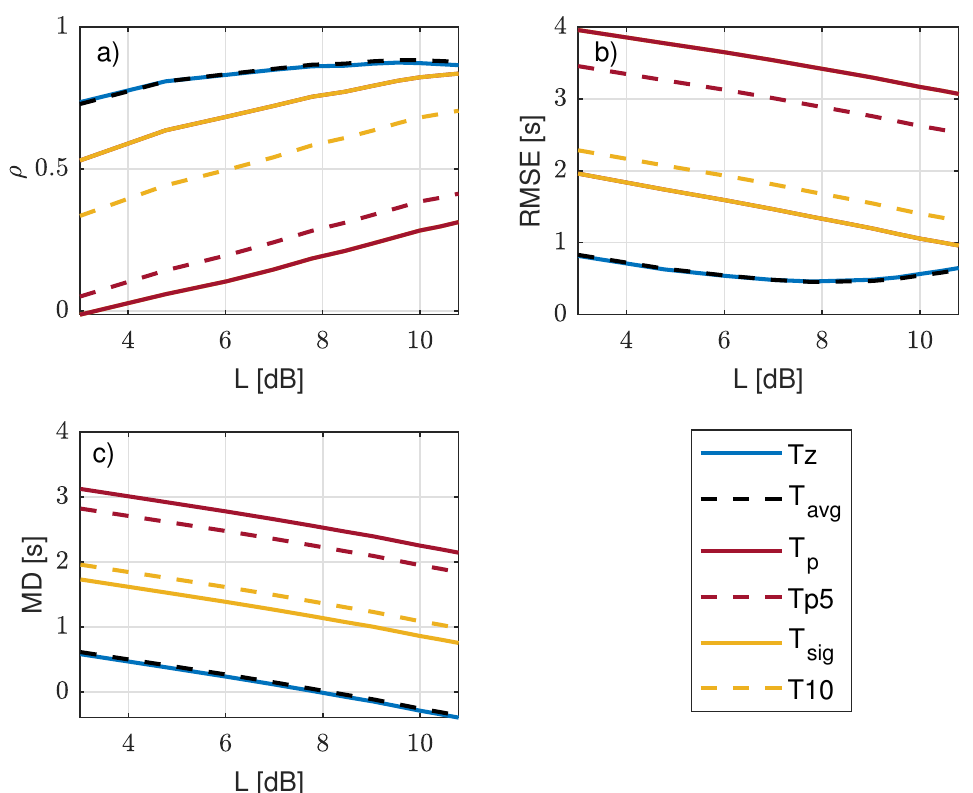
Figure 8. Comparison with 3 statistical indicators of agreement between estimated T L − dB and reference wave periods from IJmuiden campaign’s experimental data at different L values: ( a ) correlation coefficient, ρ , as a function of threshold level, L; ( b ) that for root-mean-square error (RMSE) (Equation (25)); and ( c ) that for mean deviation (MD) (Equation